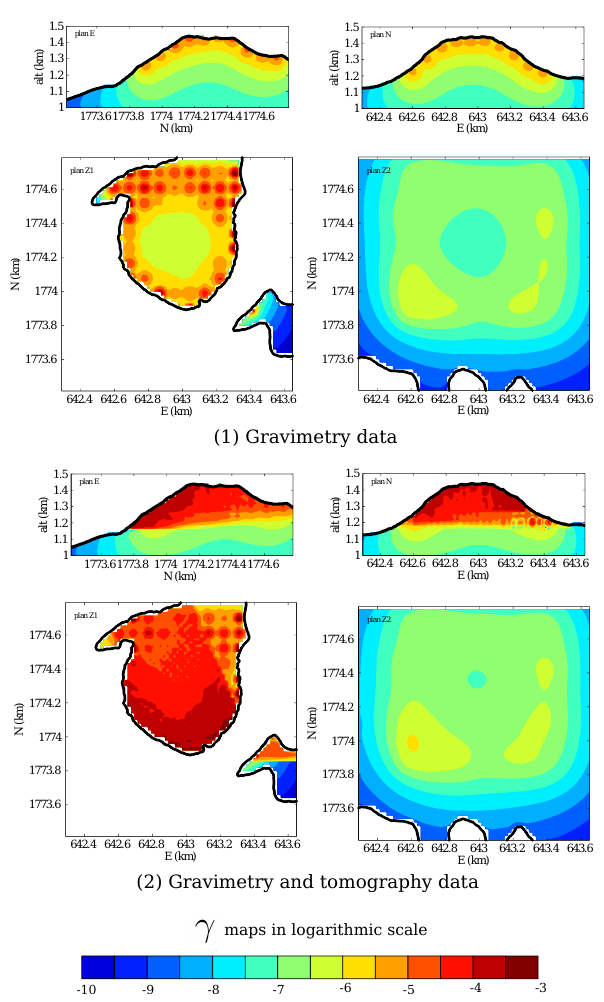
Figure 8. Representation of | γ | on the four slices defined in Fig. 5. The results are represented with a log 10 scale for (1) only gravime- try and (2) gravimetry and tomography data.